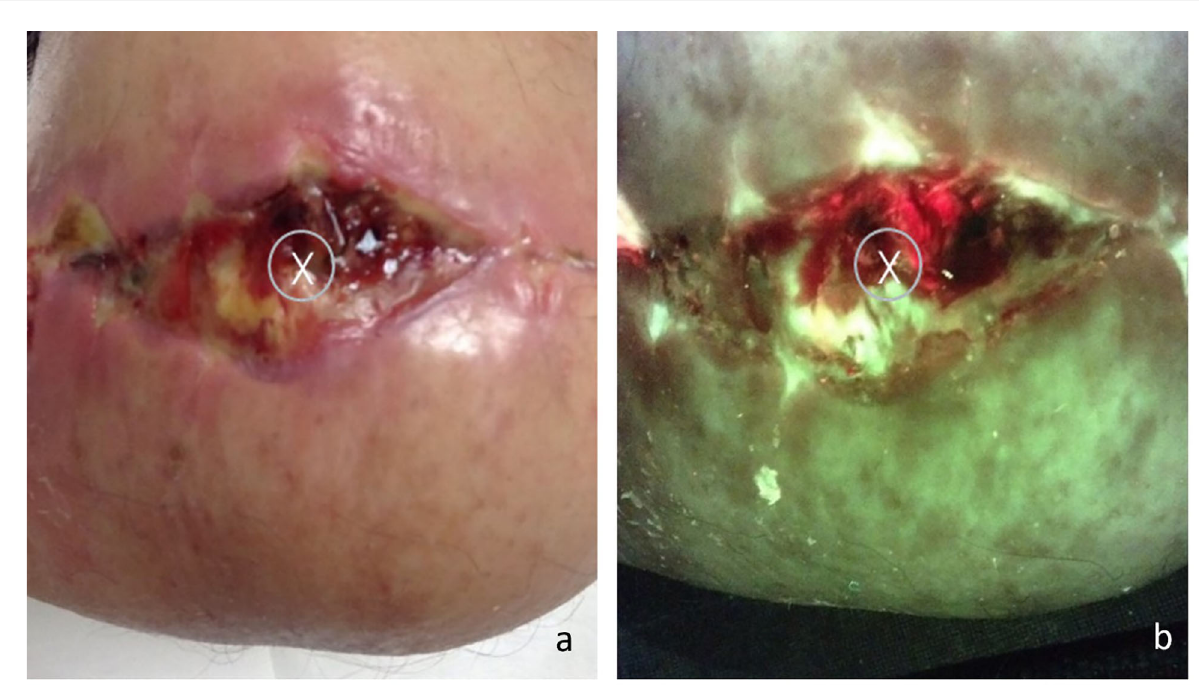
FIGURE 2 (A) Standard image of a stump wound, “ X ” marks the sample site as indicated by standard of care (center of the wound); (B) Fluorescence image of the same wound, center of the wound displays a positive red fl uorescence image, indicative of gram -/+ presence at loads >10 4 CFU/g. The coincidental overlap between SoC and area positive for FL accounted for 30% of the single-biopsy